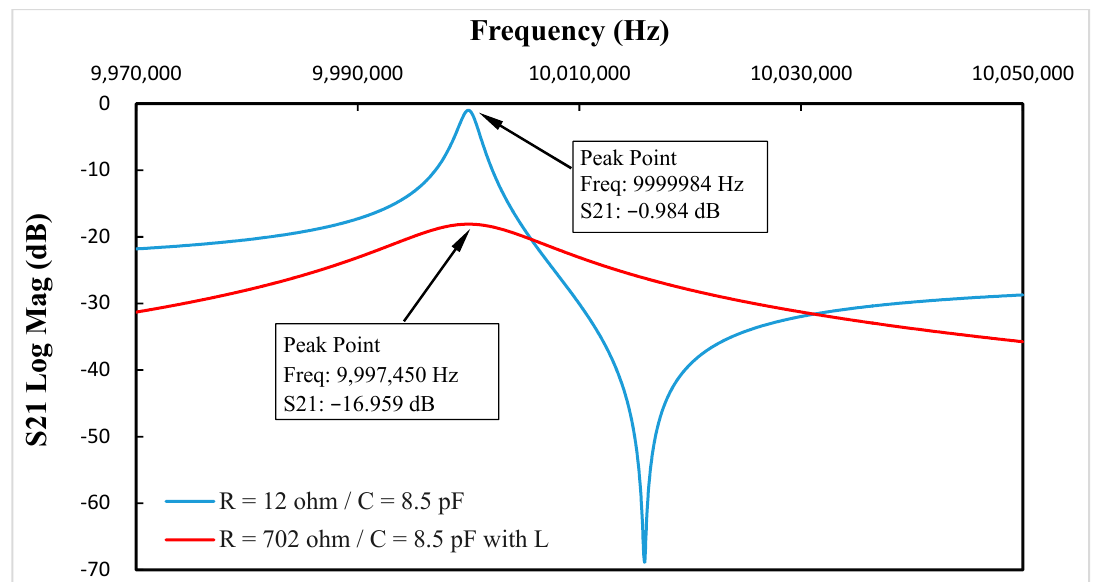
Figure 7. When (cid:1829) ∗ =8.5 pF, the S21 parameters vs. frequency curve after the addition of Figure 7. When C ∗ = 8.5 pF, the S21 parameters vs. frequency curve after the addition of inductance L a inductance (cid:1838) (cid:3028) .